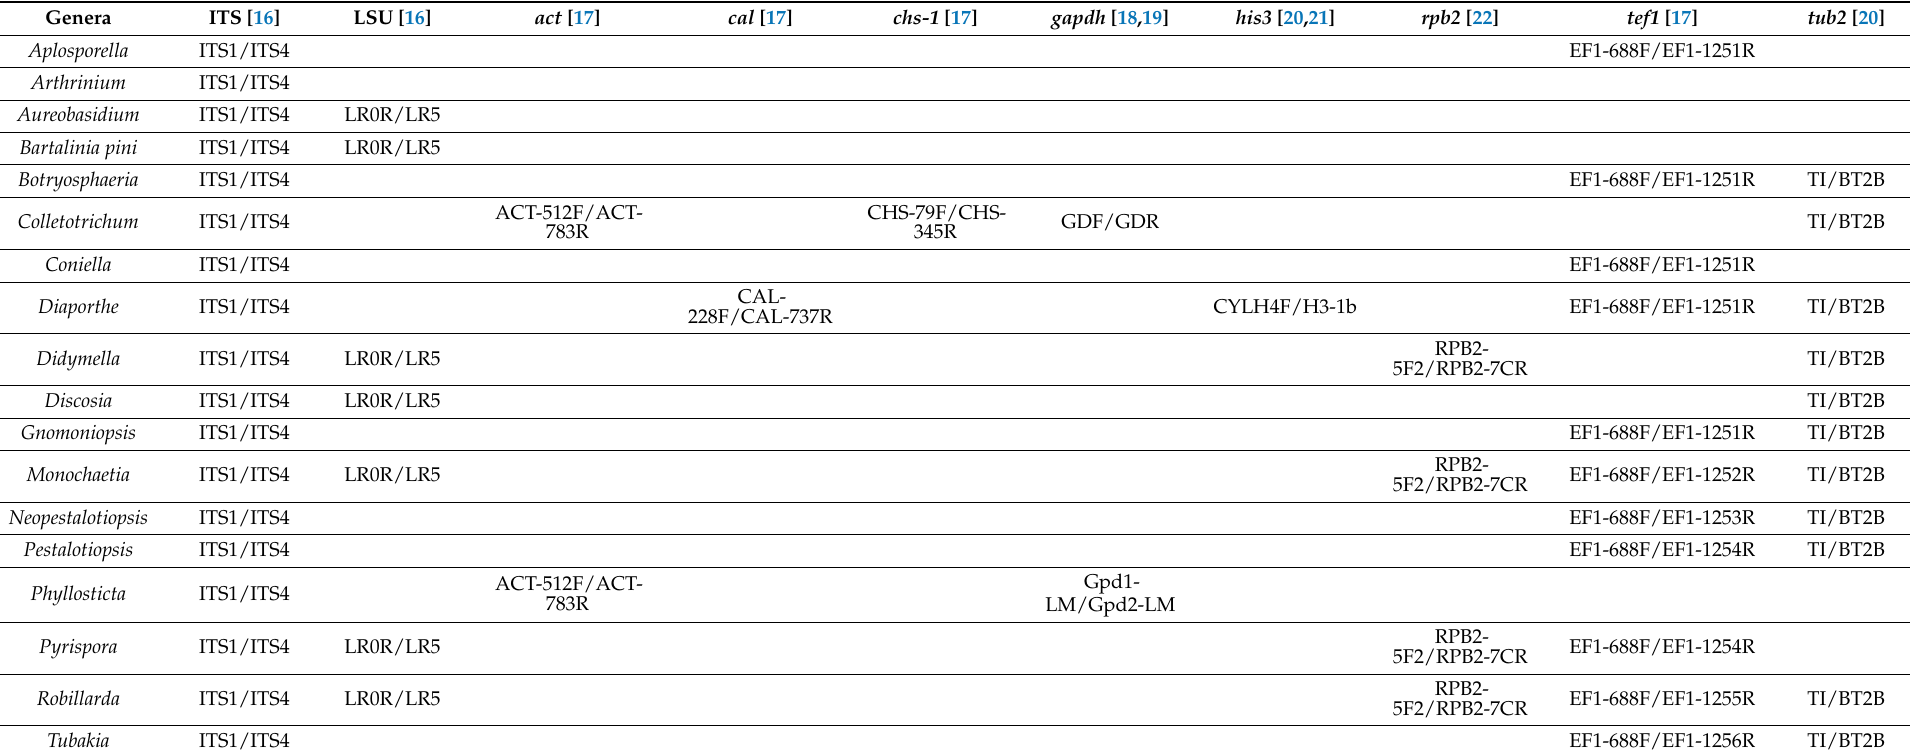
Table 1. Selected genes and primers for polymerase chain reaction of each